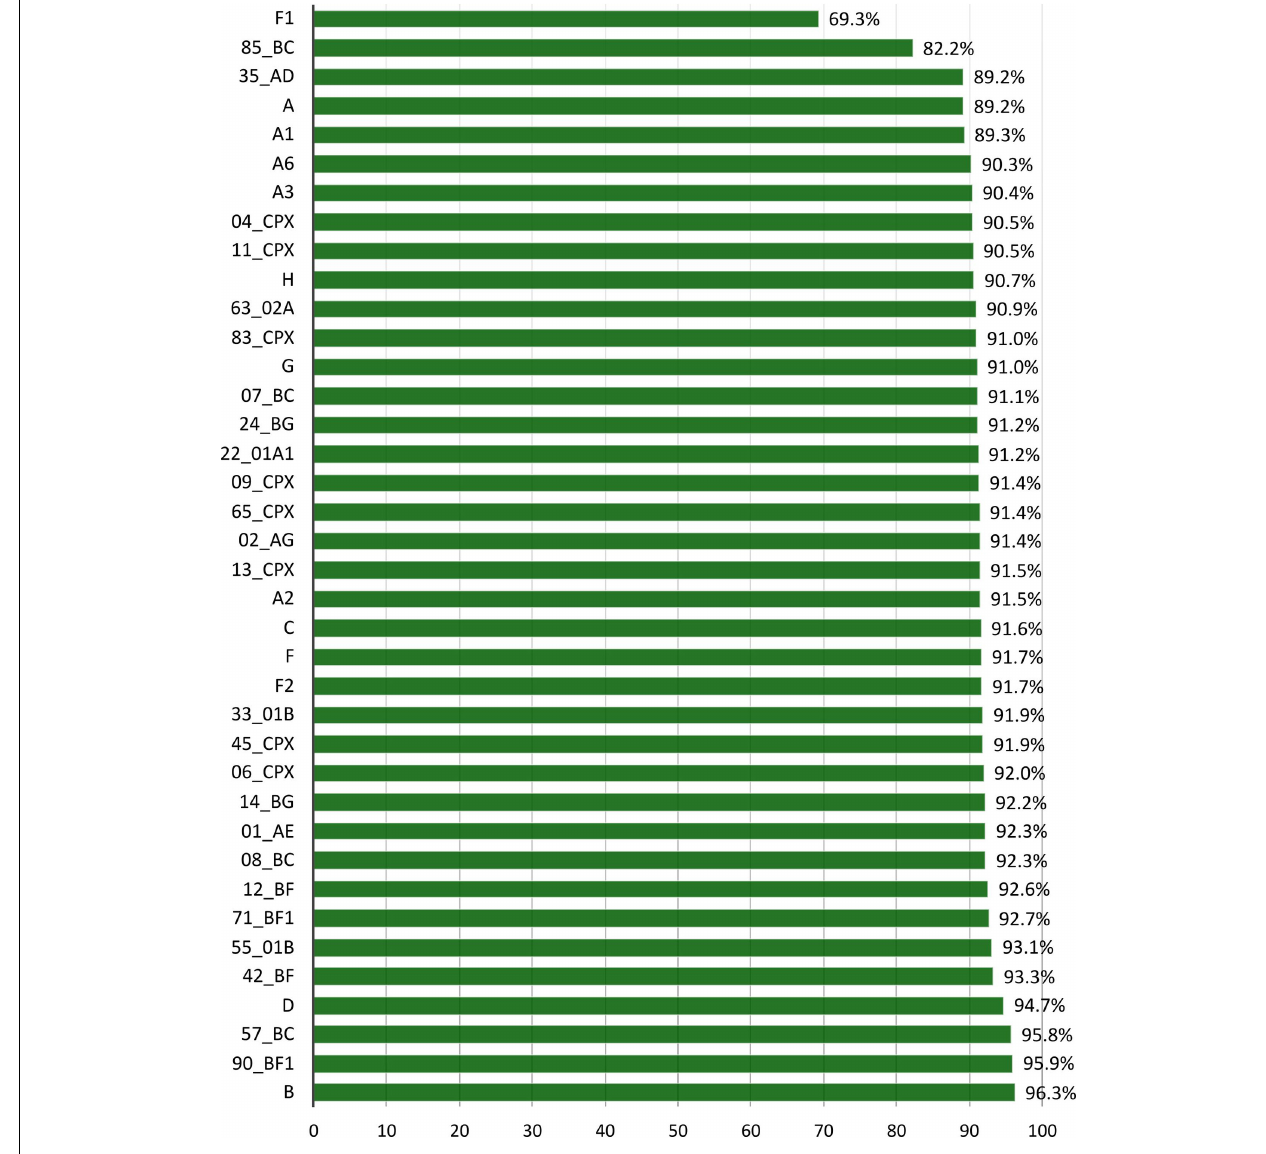
FIGURE 4 | Percentage of aa conservation of p24 across the 38 HIV-1 group M variants with ≥ 10 p24 sequences at LANL. X -axis: HIV-1 group M variants with at least 10 available sequences. Y -axis: mean p24 conservation percentage for each variant included in this